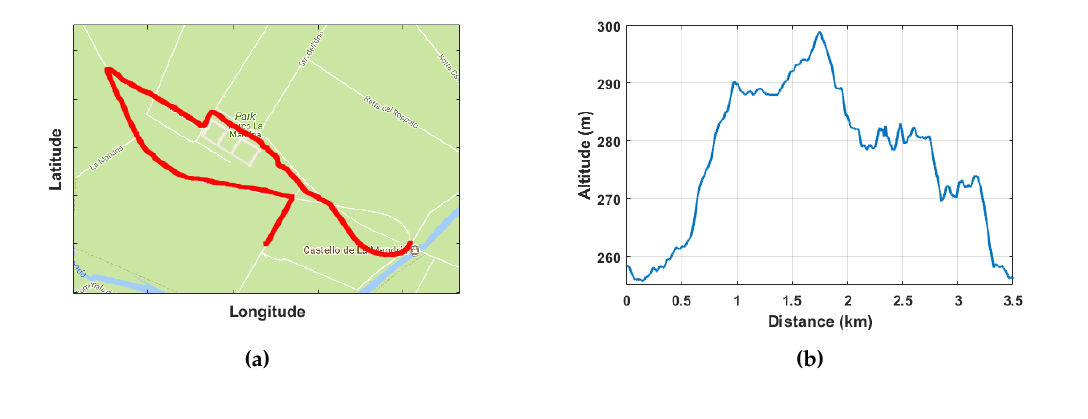
Figure 9. ( a ) GPS tracking; ( b ) altitude.